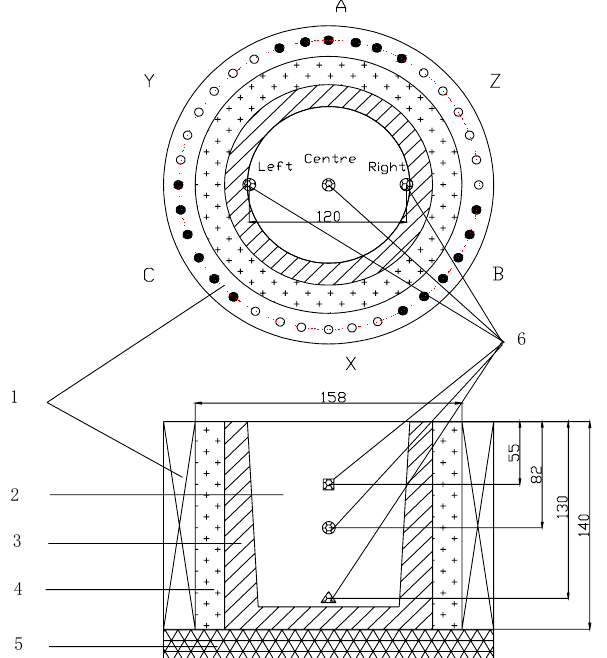
Figure 9. Schematic diagram of one of the home-made electromagnetic stirring apparatus 29 (1) electromagnetic coils, (2) the melt; (3) graphite mold; (4) thermal insulation materials; (5) thermal insulation subplate; (6) measuring positions of the magnetic flux density.